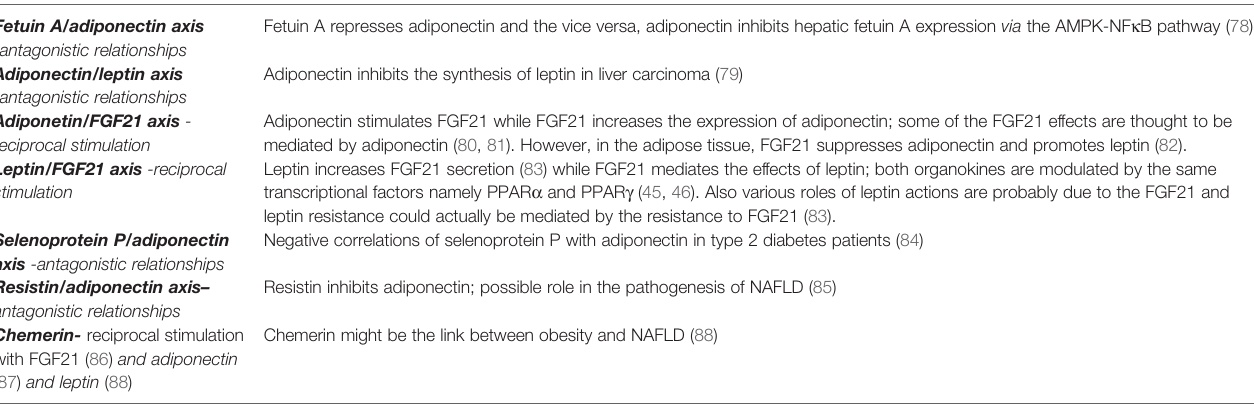
TABLE 2 | Correlations between various hepatokines and adipokines with a possible role in the pathogenesis of non-alcoholic fatty liver disease. Fetuin A/adiponectin axis -antagonistic